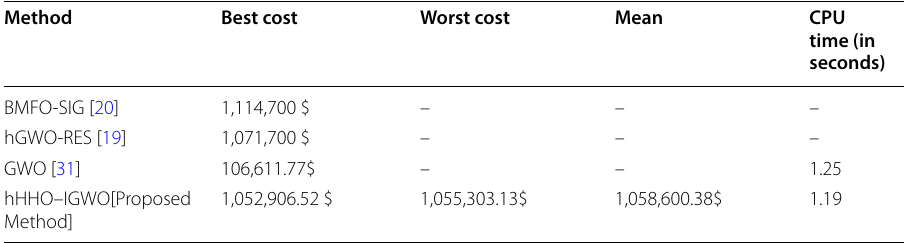
Table 9 Comparison of 20-unit wind–thermal system with other algorithms Method